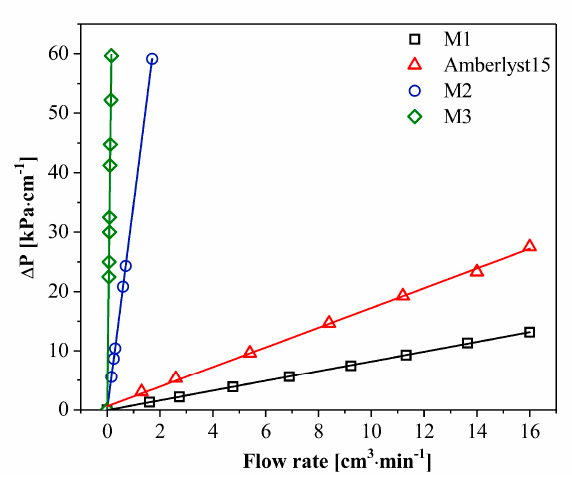
Figure 5. Pressure drop vs. flow rate in microreactors and the packed bed reactor with Amberlyst 15.